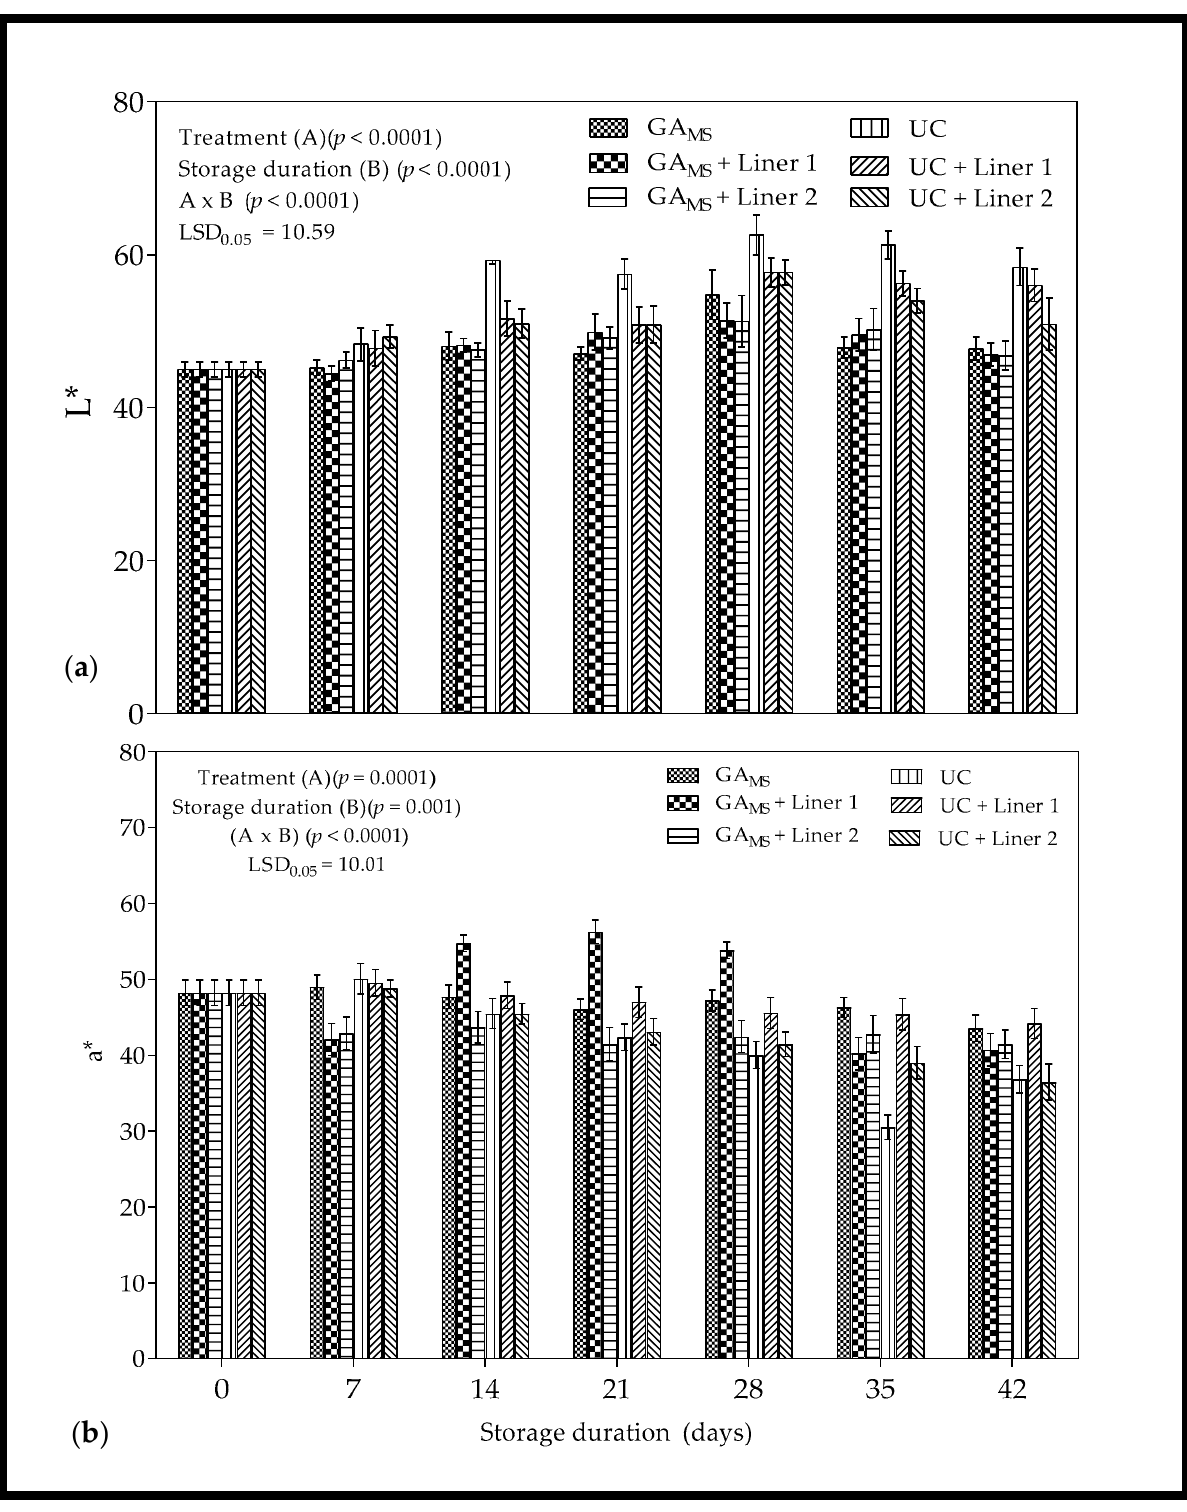
Figure 5. Color attributes ( a ) lightness (L*) and ( b ) redness/greenness (a*) of ‘Wonderful’ pomegranate coated and packaged in different polyliners and stored (5 ± 1 ◦ C, 95 ± 2% RH) for 42 d. GA MS —gum Arabic (0.5% w / v ) and maize starch (0.5% w / v ); Liner 1—Xtend ® liner (20 µ mm perforations); Liner 2—perforated liner (4 mm perforations); UC—uncoated fruit. LSD 0.05 represents least significant difference ( p < 0.05).